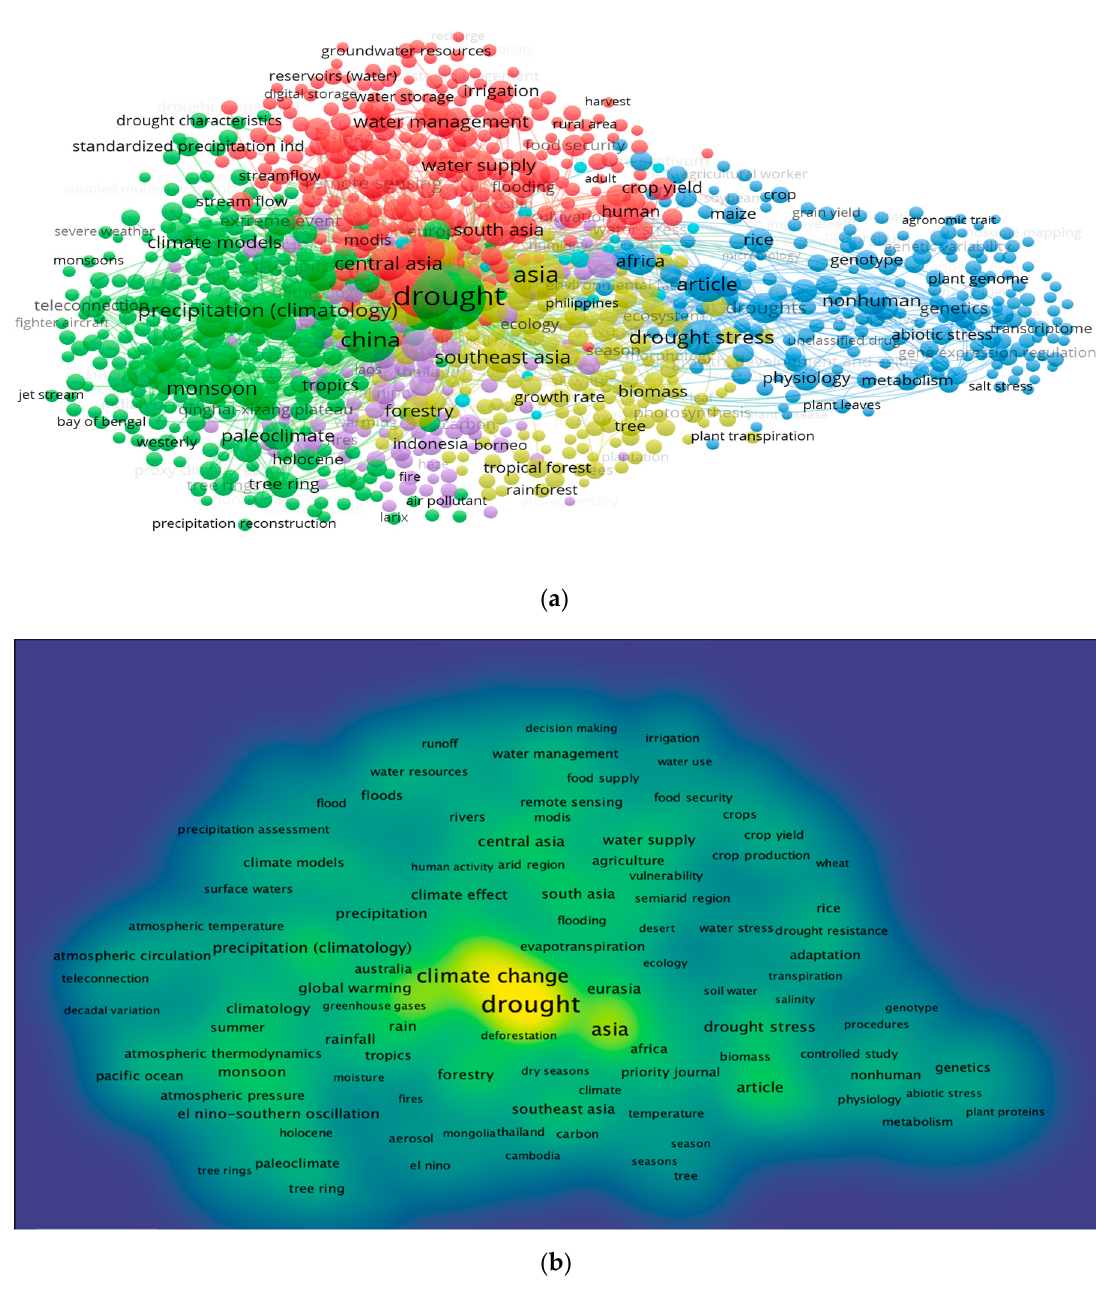
Figure 4. ( a ) . Mapping of keywords for drought analysis: Co-occurrence visualization. Green: Drought, precipitation, climate models. Red: Water management, water supply. Blue: Drought stress, crop, grain yield. Yellow: Rainforest, Asia, biomass. ( b ). Density visualization for drought analysis. Table 1. Top twenty keywords . Keyword